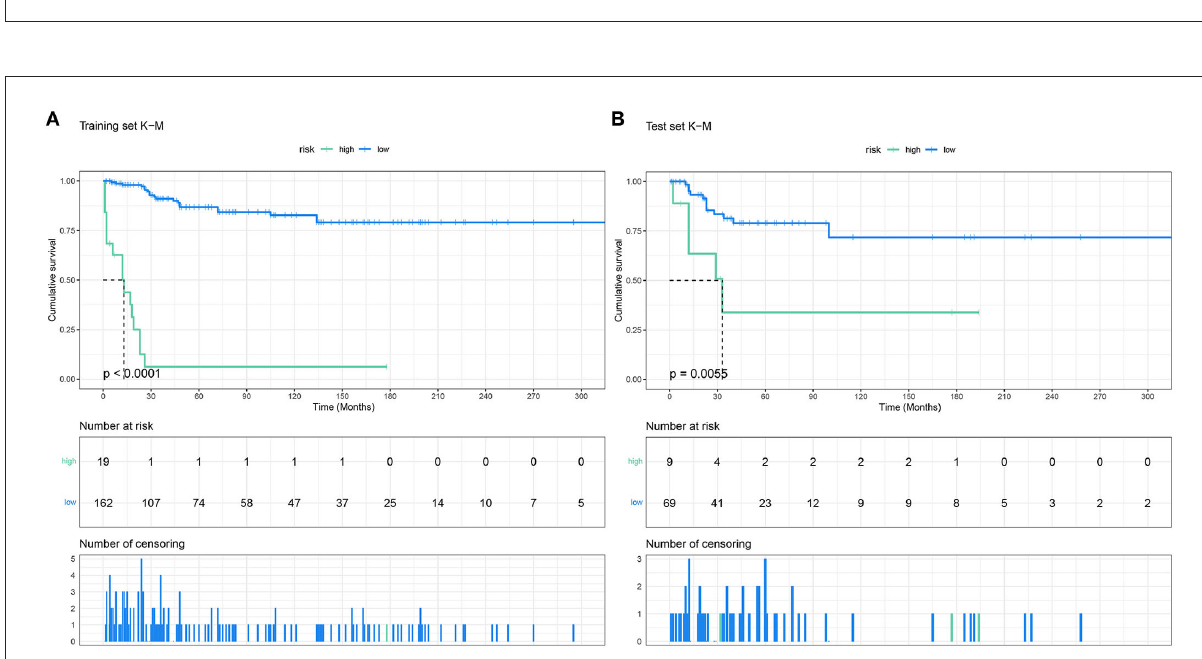
FIGURE5 The calibration curves of the nomogram for the 12 (A) , 36 (B) , and 60 (C) months in the validation set. The decision curve analysis of the nomogram for the 12 (D) , 36 (E) , and 60 months (F) in the validation set.